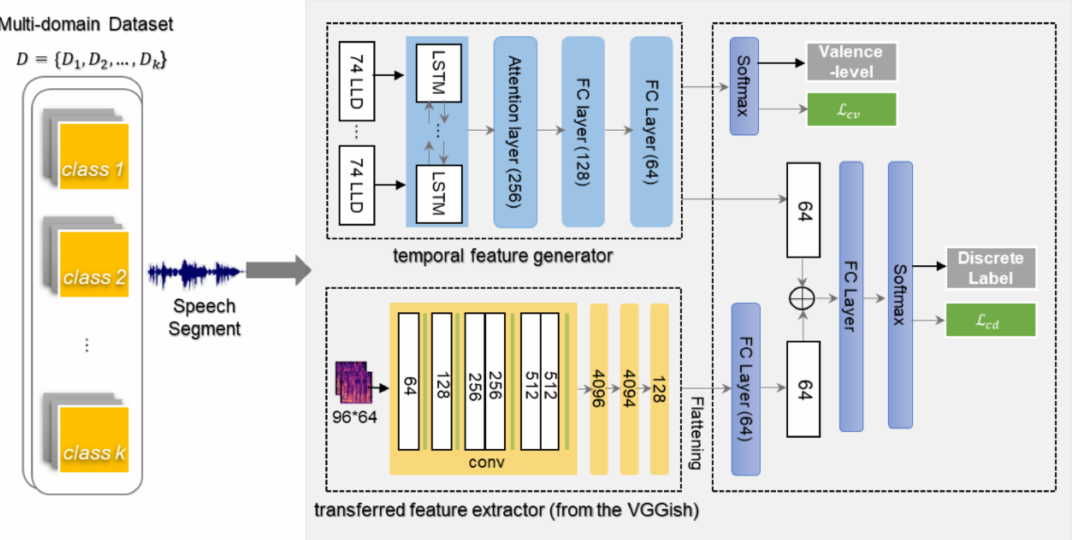
Figure 2. Architecture of the multi-path and group-loss-based network for SER. The MPGLN SER model comprises a bidirectional long short-term memory (BLSTM)-based temporal embedding generator and a transferred feature extractor from the VGG-like audio classification model (VGGish) and its prediction